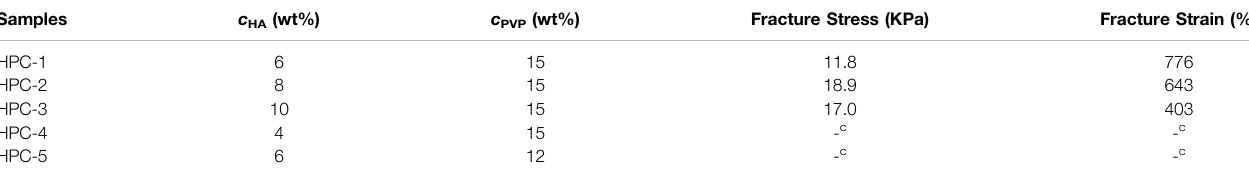
TABLE 1 | Composition and mechanical parameters of the prepared HPC hydrogels.